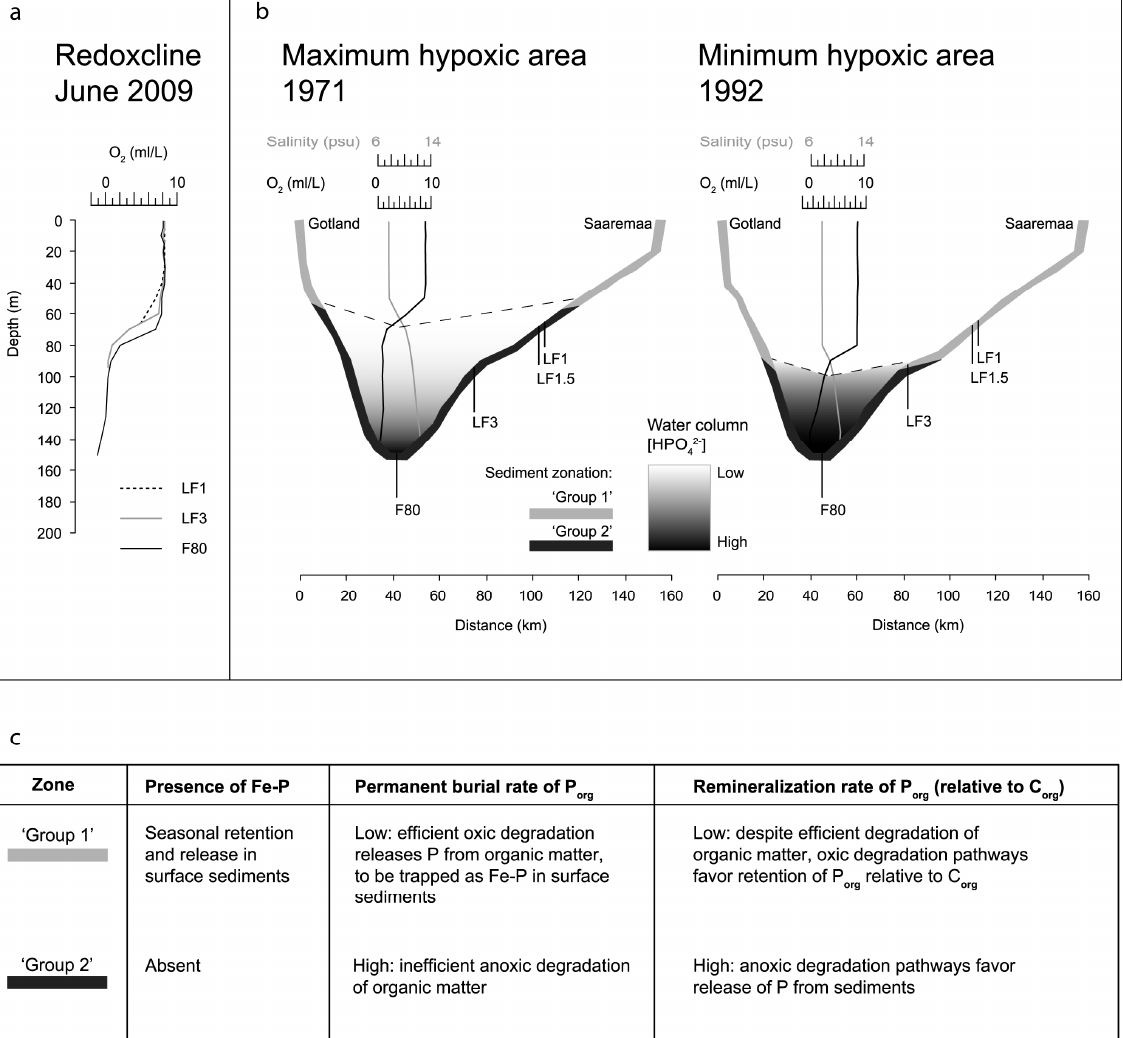
]. Sediment zones are divided based 4